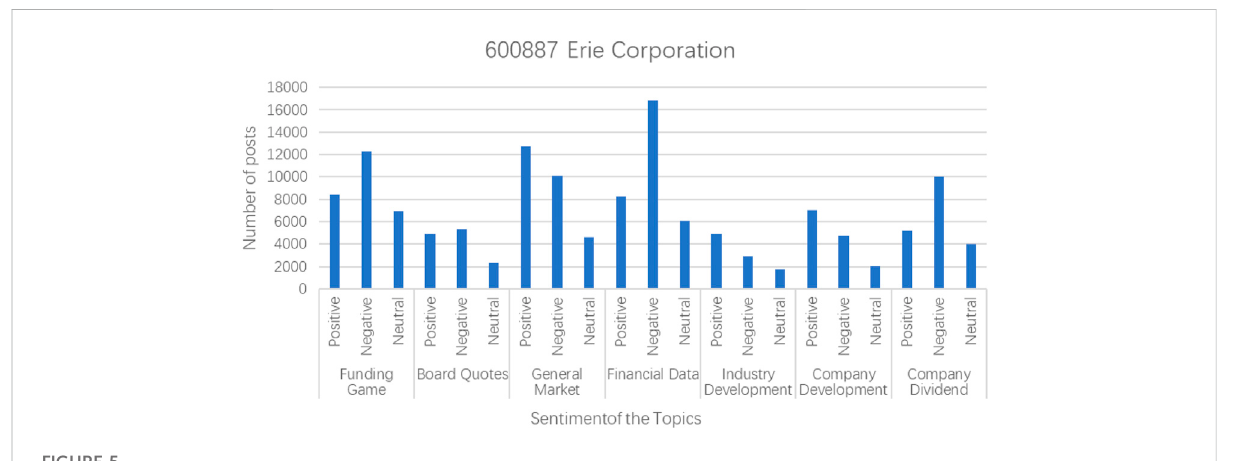
FIGURE 5 Sentiment analysis results of speci fi c stock texts.